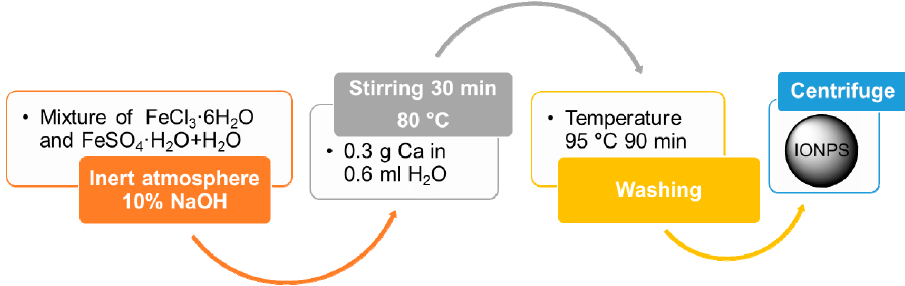
Figure 2. Flowchart for the synthesis of IONPs by co-precipitation [19]. In this example, Fe 3 O 4 NPs are prepared from a mixture of FeSO 4 and FeCl 3 in the molar ratio of 1:2. Magnetic phase and particle size can be adjusted by varying Fe 2+ /Fe 3+ ratio, temperature, pH, and the type of base used.